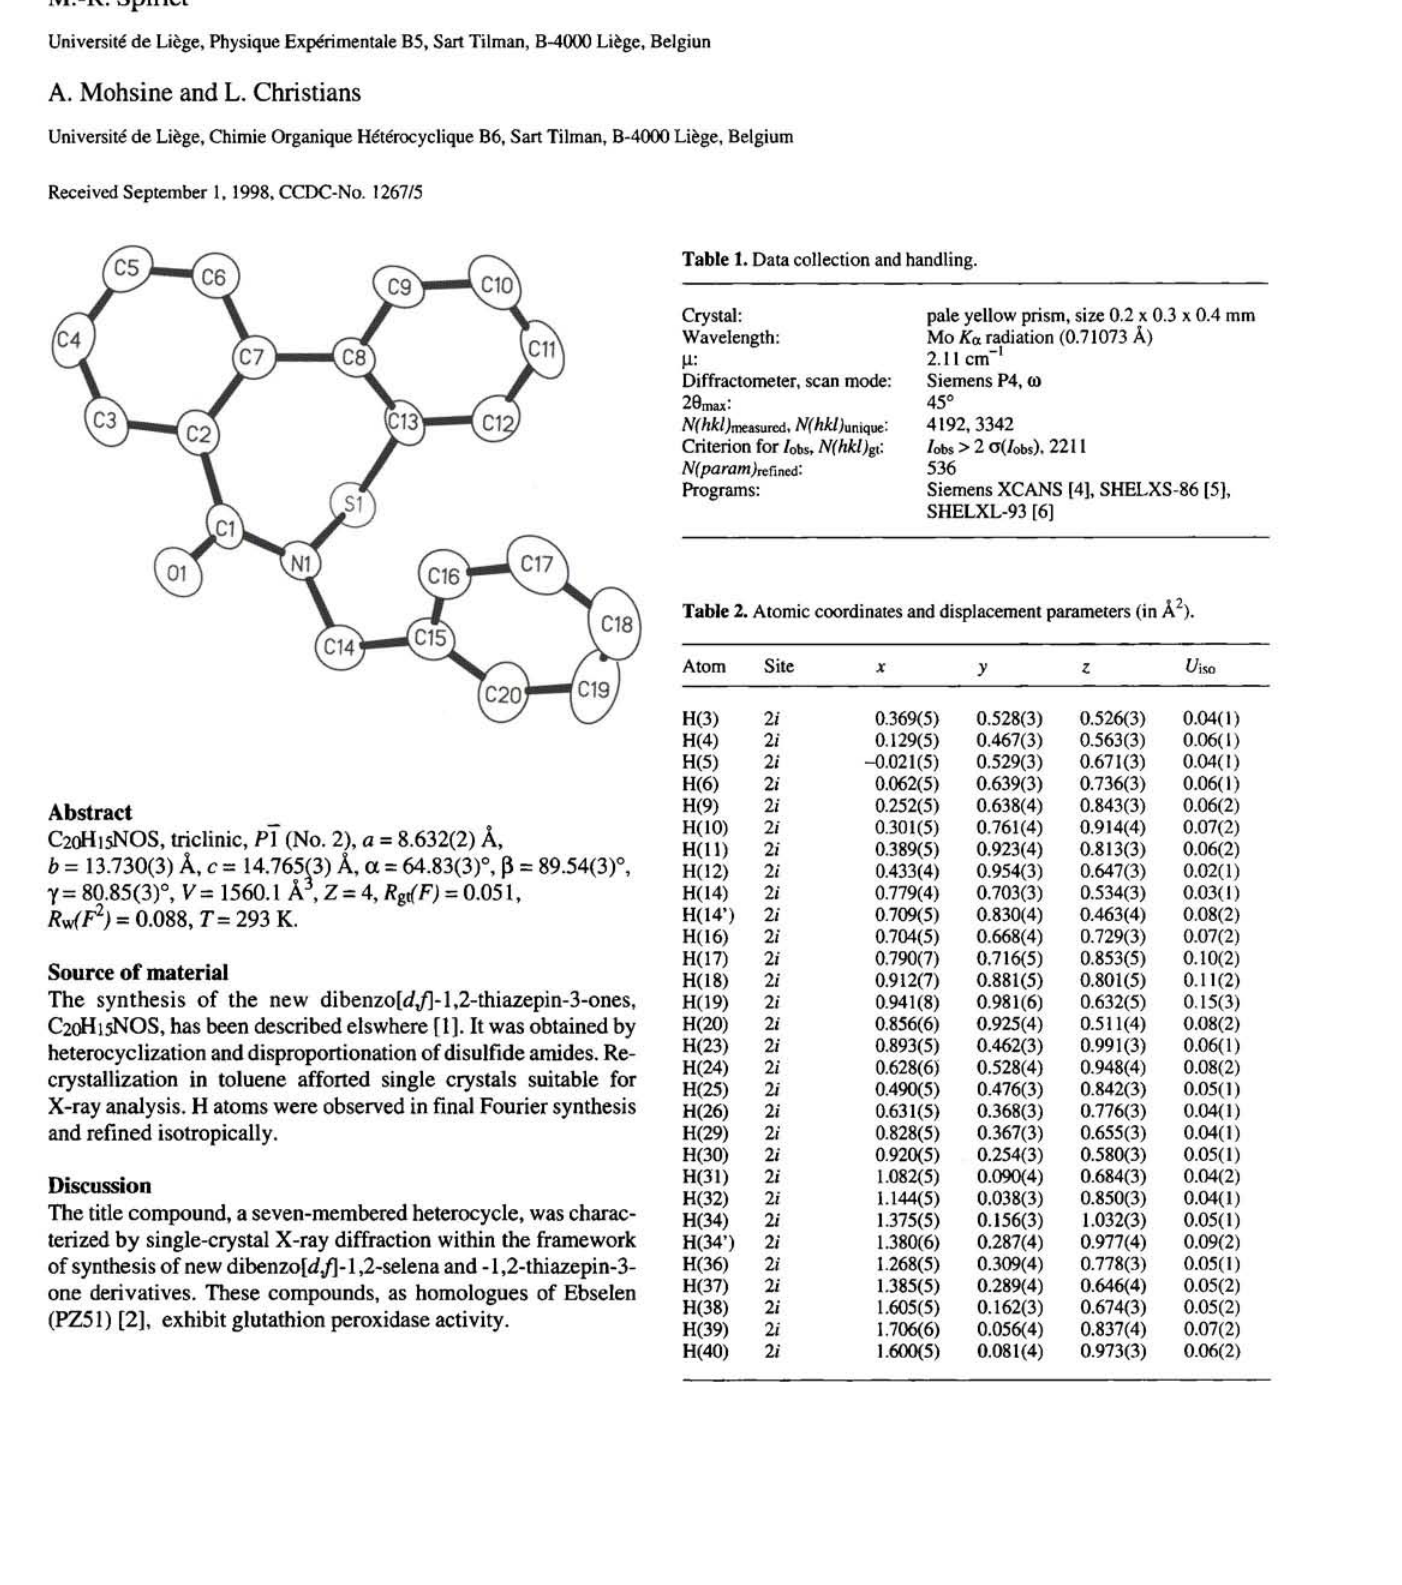
Table 1. Data collection and handling.